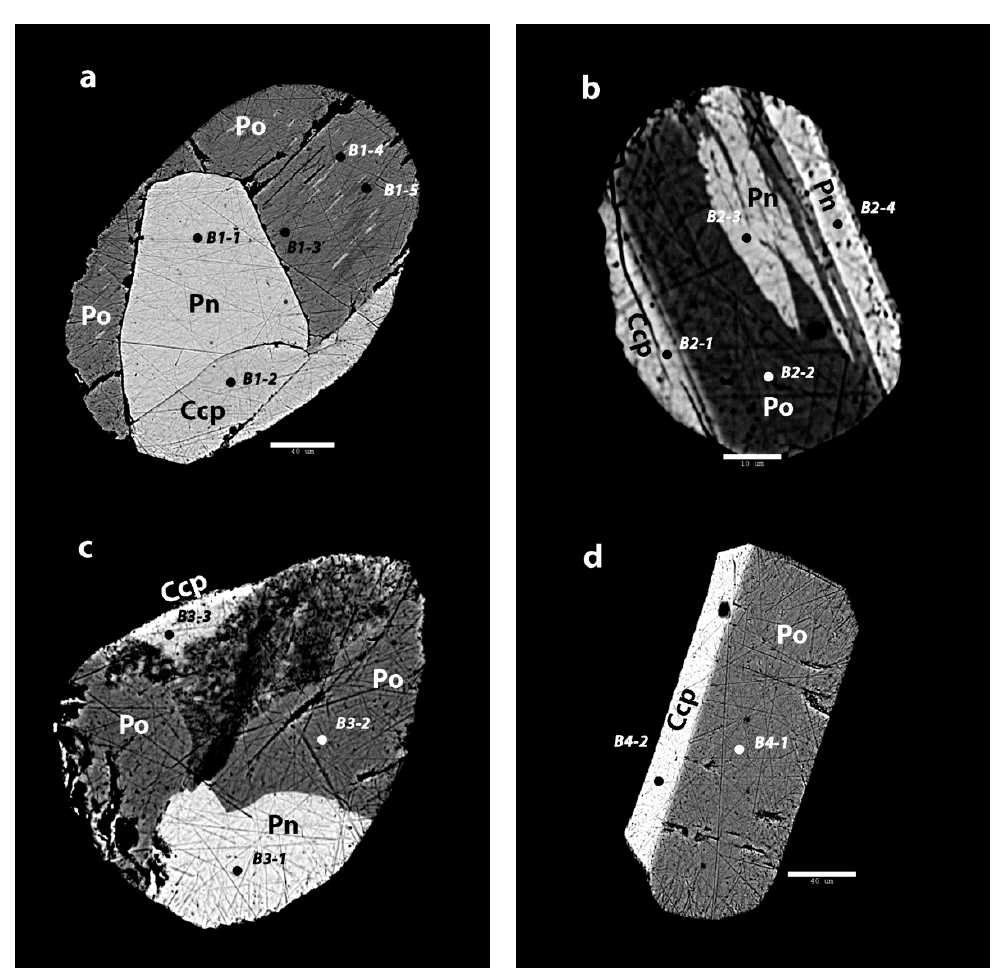
Figure 4. Back scattered electron images of the sulfide inclusions in Mozambican ruby. ( a ) The inclusion in sample B1 shows three main phases, of which one has various exsolutions. Scale bar: 40 µm; ( b ) In sample B2, there are three phases with two phases that show exsolution patterns. Scale bar: 10 µm; ( c ) In sample B3, there are three distinct phases. The darker phase shows deeper polish lines and large pits, which might indicate a more unstable mineral. Scale bar: 20 µm; ( d ) B4 shows two clearly separated phases without any exsolution textures. Scale bar: 40 µm.